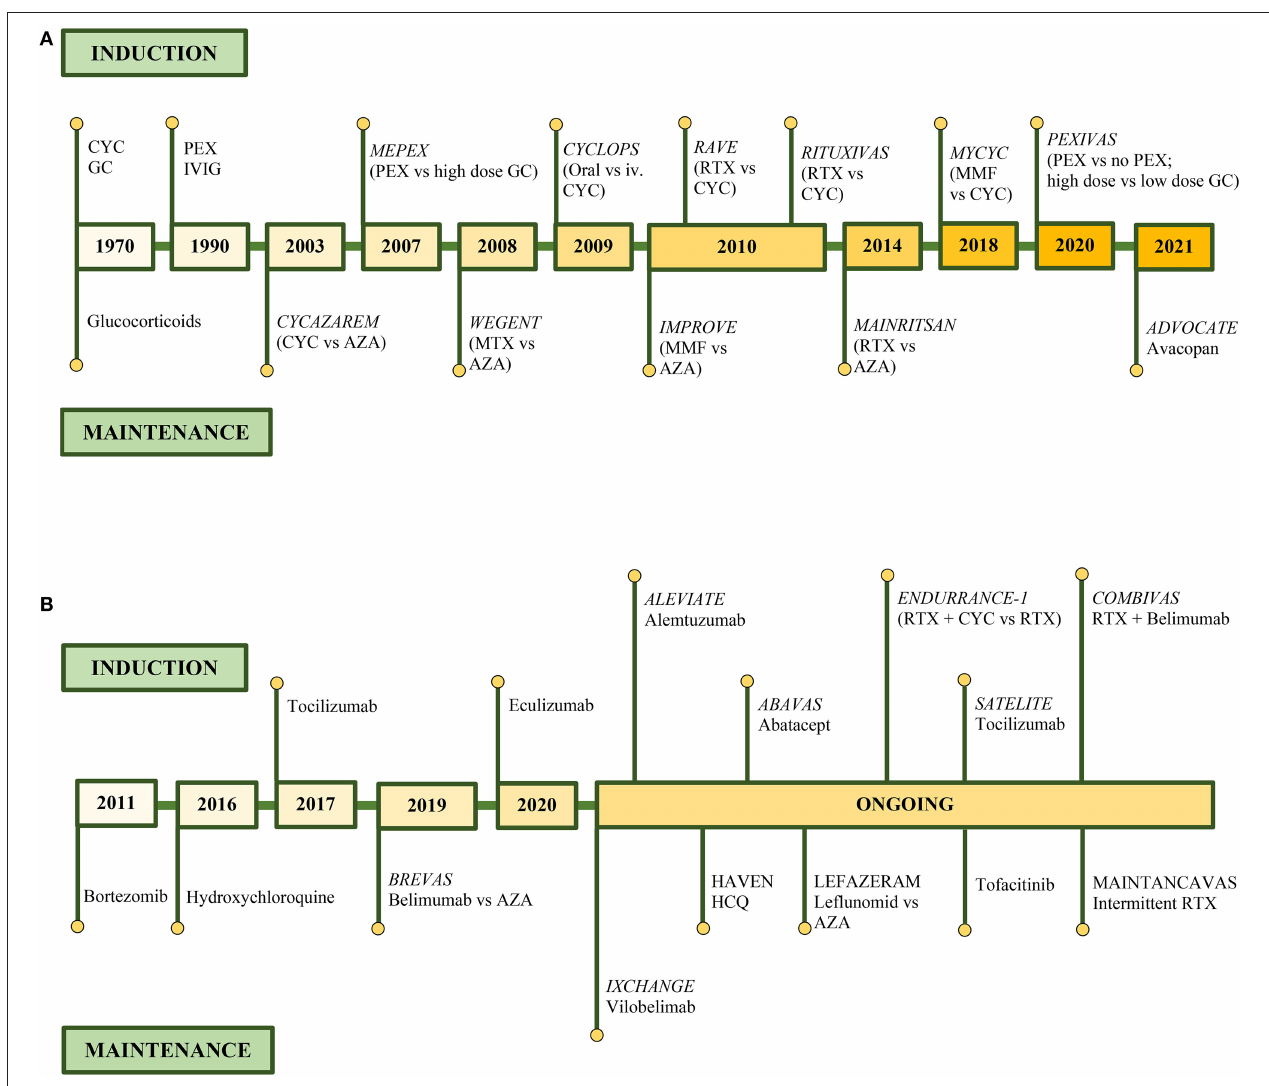
FIGURE 4 | Therapeutic evolution of ANCA-associated glomerulonephritis. Clinical trials in remission induction and maintenance therapy of currently used medications (A) , and medications with positive outcome but currently not presented in guidelines and on-going clinical trials (B) .